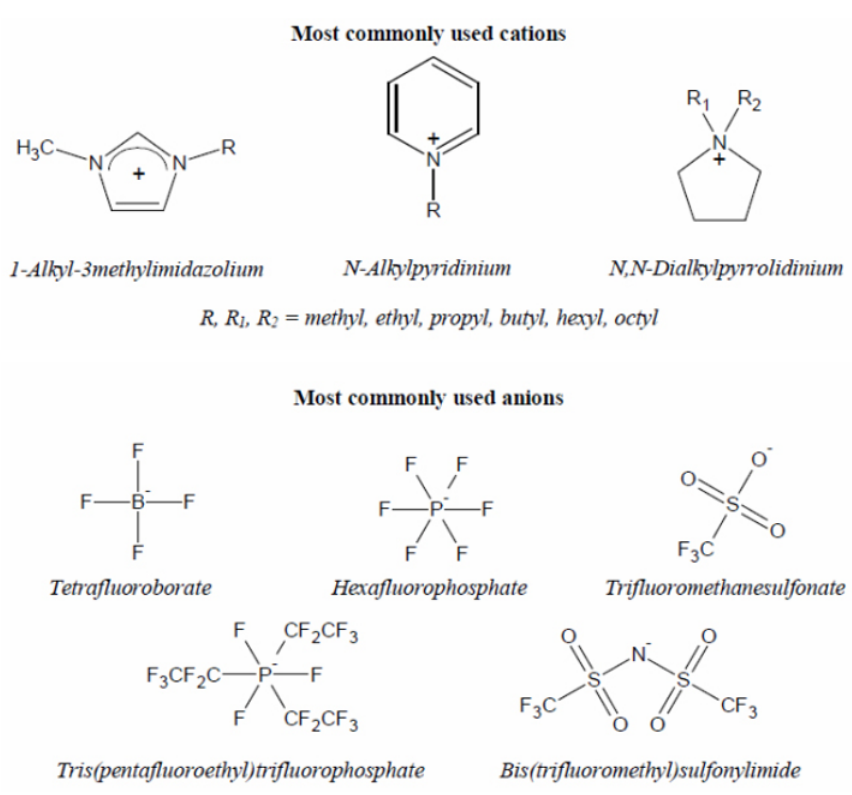
Figure 2. Structures of the cations and anions of the most commonly used ILs.